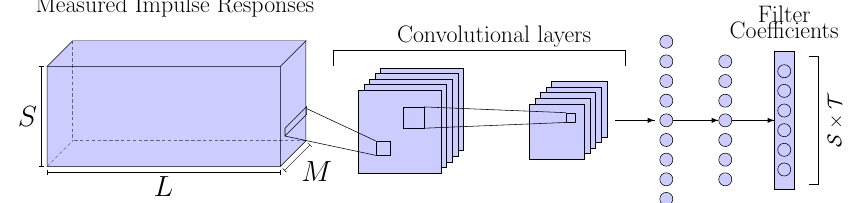
Figure 3. Scheme of the proposed method using a Convolutional Neural Network